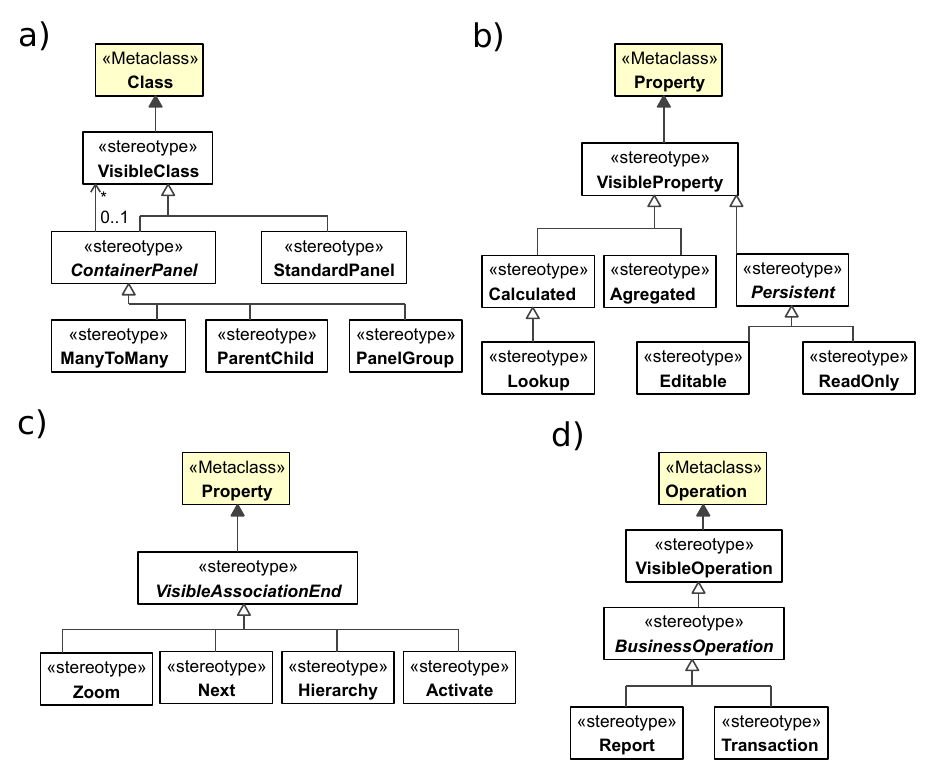
Figure 5. The most important elements of the EUIS UML profile: ( a ) Visible classes (panels), ( b ) visible properties, ( c ) visible association ends, and ( d ) visible operations.